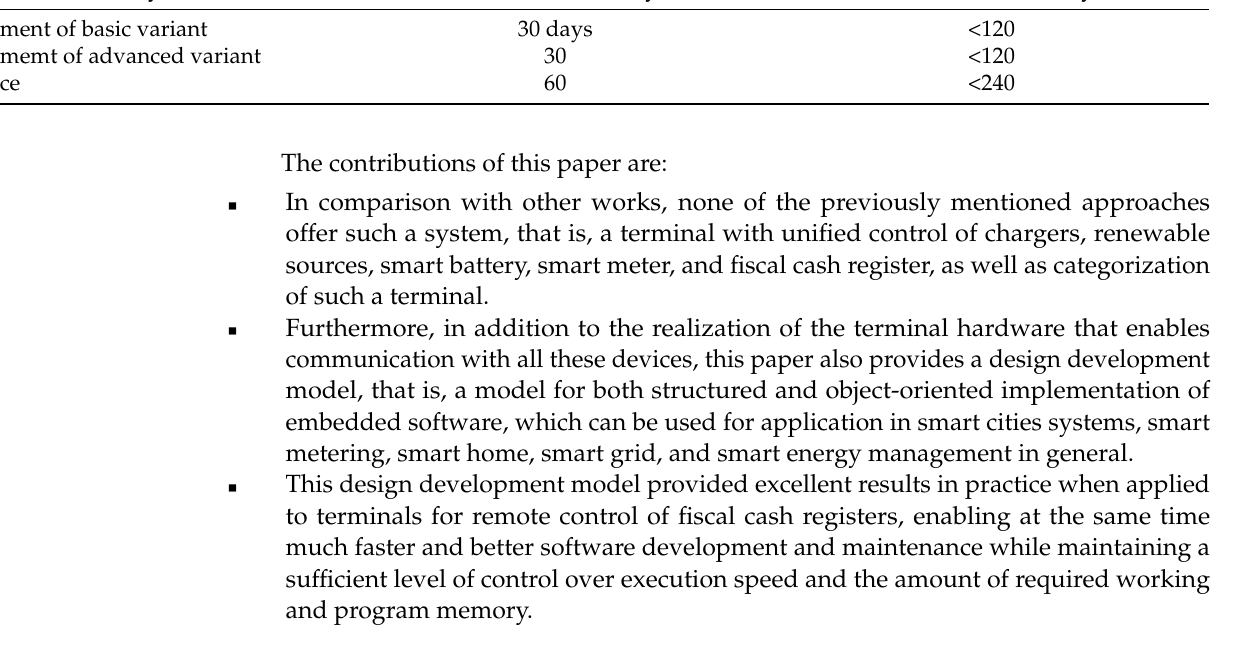
Table 4. The simulation of applying model-driven development method to the terminal for remote control of the station.